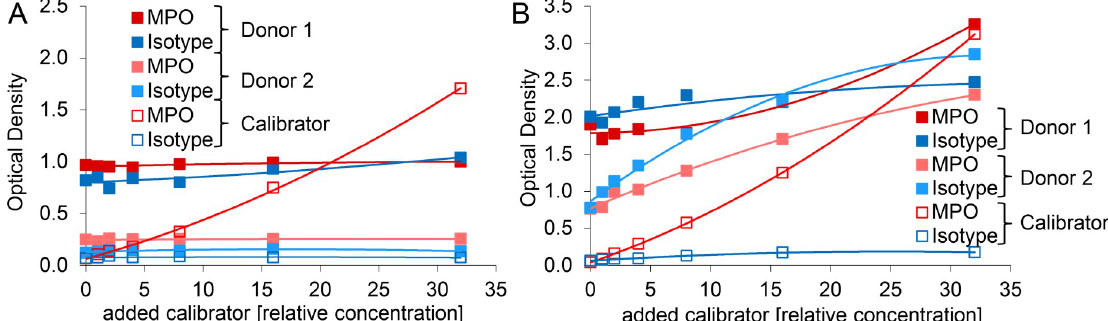
Fig 6. Detection of in vitro generated MPO-DNA complexes is abrogated when spiked into plasma. Microwells were coated with MPO antibody or isotype control. Increasing amounts of calibrator (relative concentration of supernatant of PMA stimulated neutrophils) were added to plasma of two distinct donors which was A) 1:4 or B) 1:100 pre-diluted with sample diluent. Calibrator without plasma was additionally measured (open symbols). Samples were further processed according to the initial MPO-DNA complex ELISA protocol. Note that an added relative calibrator concentration of “0” represents plain plasma at the respective